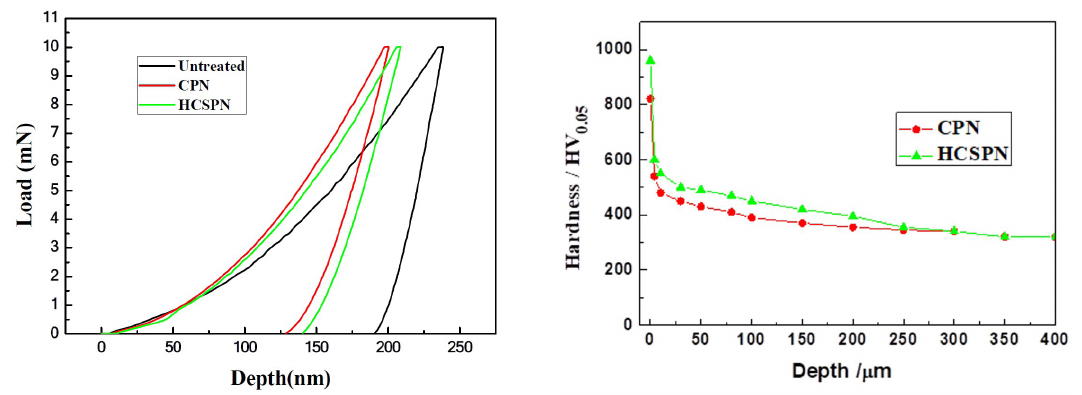
Figure 8. Microhardness distributions with depth for CPN and HCSPN